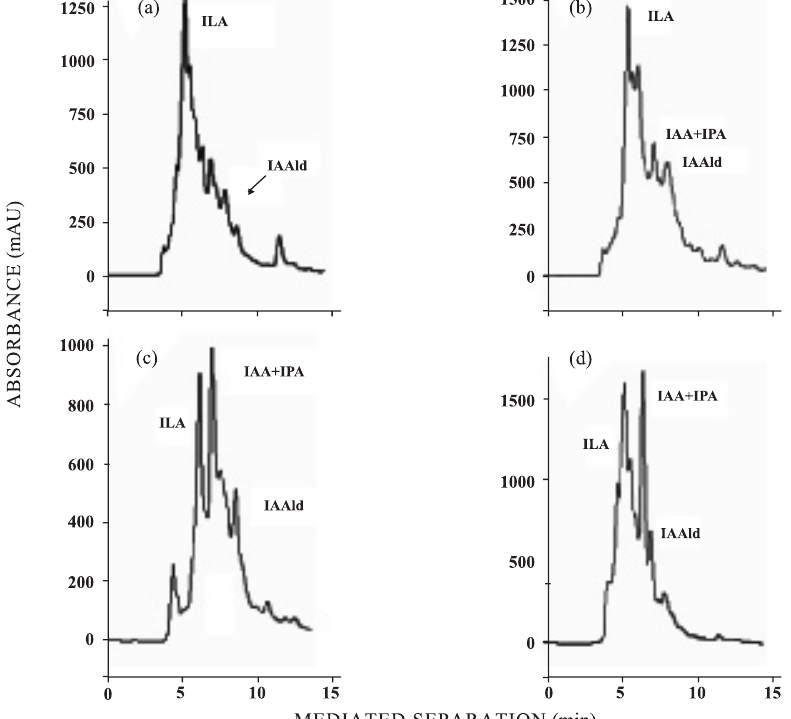
Figure 2. HPLC-mediated separation of indole compounds in rhizobacterial culture supernatants: (a) Burkholderia sp., (b) Curtobacterium sp., (c) Enterobacter sp. and (d) Bacillus sp. IAA, indole 3-acetic acid; IPA, indole 3-pyruvic acid; IAAld, indole-3-acetaldehyde; ILA, indole-3-lactic